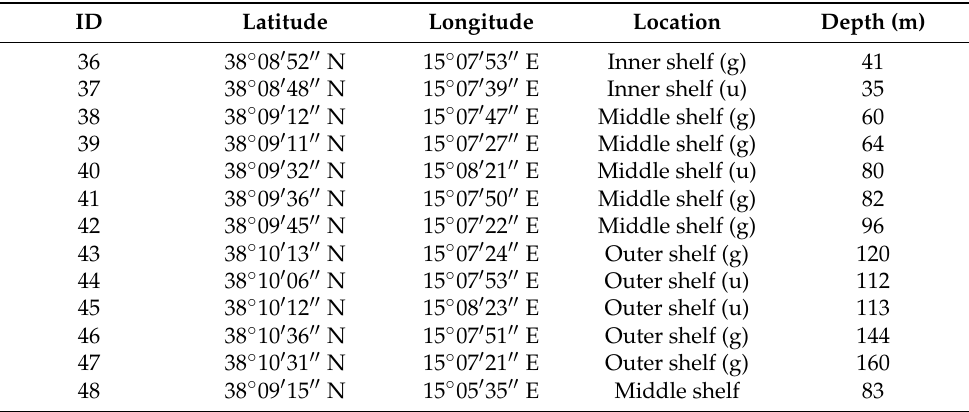
Table 1. Location and water depth of sediment samples: (g) from gullies; (u) from seafloor